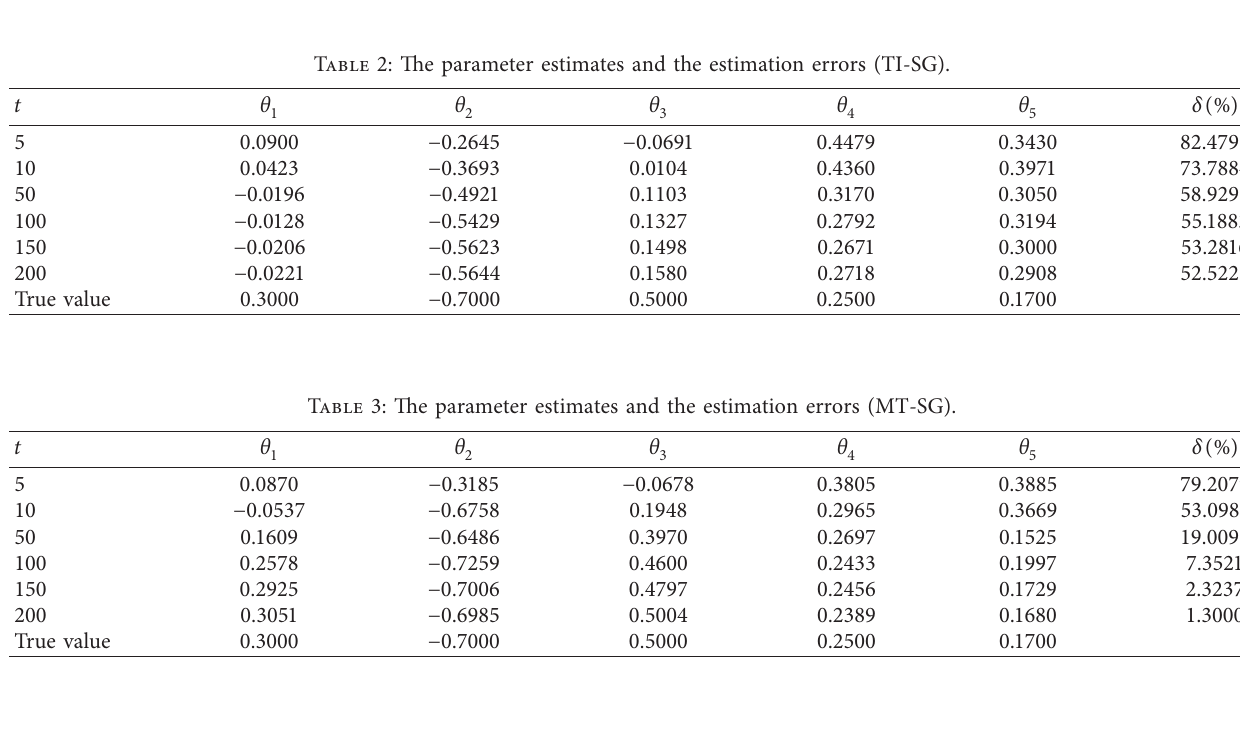
Table 4: The parameter estimates and the estimation errors